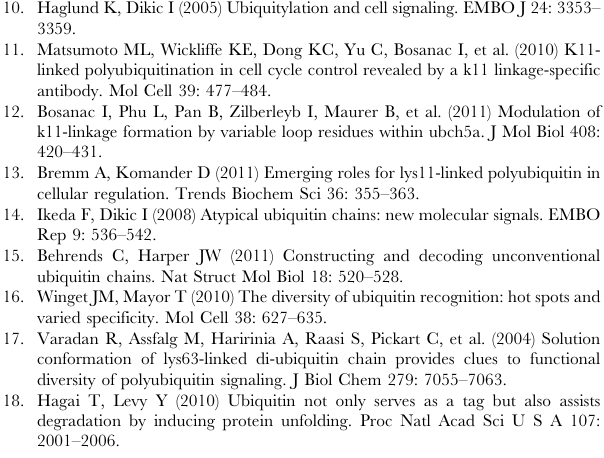
Figure S16 Comparison between conformational fluc- tuation of Ub units with experimental temperature factor. Figure S17 The matrix of hydrophobic parameters for different sidechain-sidechain interactions in the pro- tein-protein association model. (PDF) Text S1 Supporting Methods (Estimation of disassoci- ation constant, Entropy reduction estimation by a polymer theory); Tables 14; Supporting References.